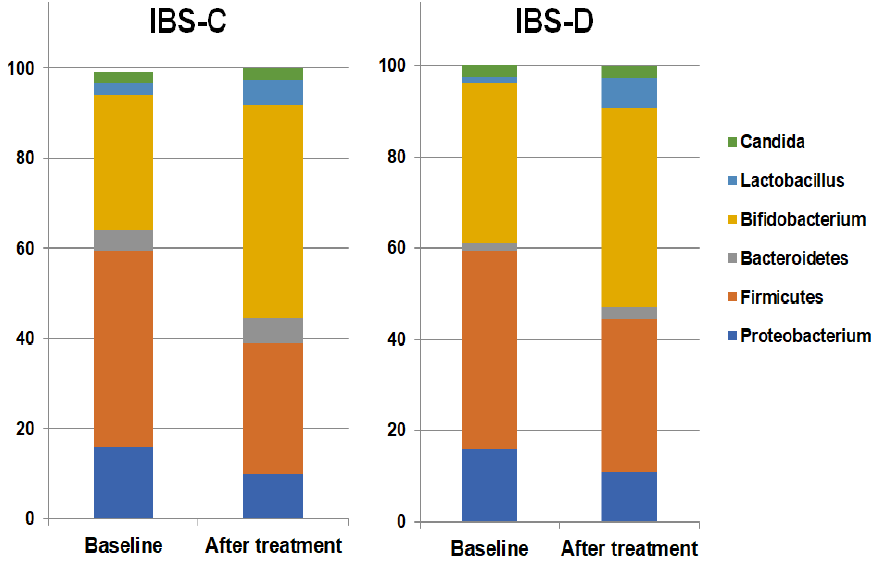
Figure 1. Effects of supplement and diagnosis on the microbiota.